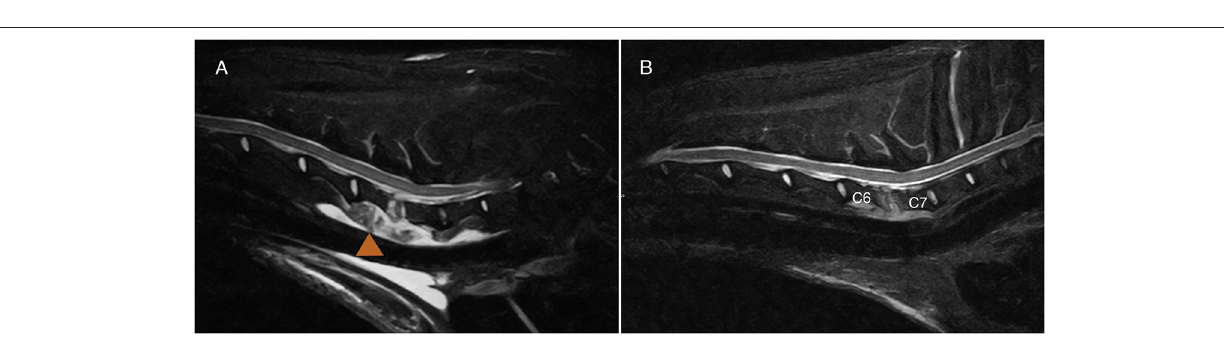
FIGURE 4 | MRI-1 (A) and MRI-2 (B) midline sagittal short-tau inversion recovery (STIR) images of the case diagnosed with C6-C7 discospondylitis following ventral slot. One month separates MRI-1 and MRI-2. Note the extensive soft tissue changes (arrowhead) which my be associated with surgical exposure. The degree of effacement and STIR hyperintensity affecting the endplates, as well as the STIR hyperintense material in the epidural space were considered beyond what is expected following surgery. The dog had cervical spinal pain despite lack of obvious neural tissue compression. The dog was “symptomatic” at the time of MRI-2 and both observers classified the case as